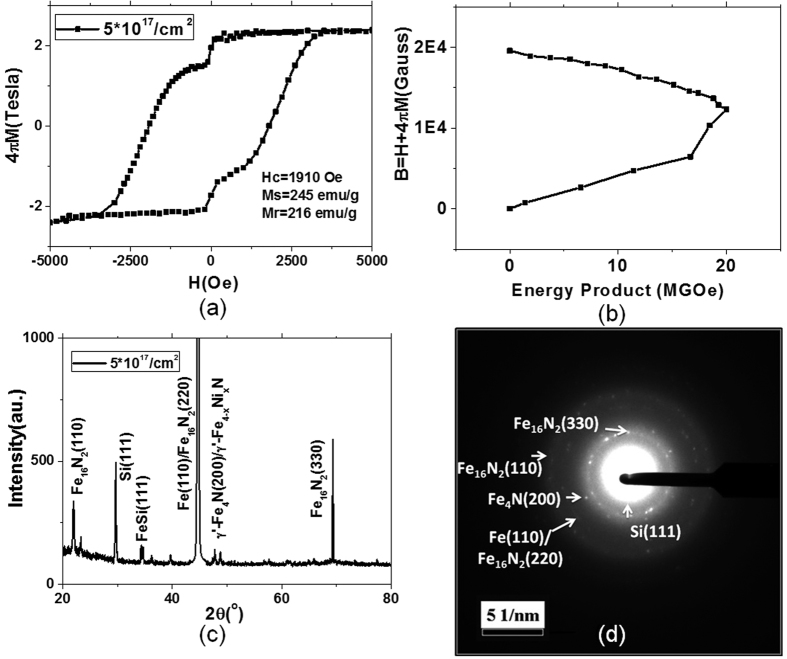
Characterization results of a bulk Fe16N2 free-standing foil prepared by the nitrogen ion implantation method with 5 × 1017/cm2 fluence (a) In-plane hysteresis loops for the sample at room temperature, showing Hc = 1910 Oe, Ms = 245 emu/g, Mr = 216 emu/g; (b) The calculated energy product, indicating maximum value 20 MGOe; (c) The X-ray diffraction spectrum, showing the Fe16N2 phase generated in the foil; (d) The HRTEM diffraction pattern of FeN sample with 5 × 1017/cm2 fluence, showing Fe16N2, Fe4N/Fe4−xNixN and Fe phases.